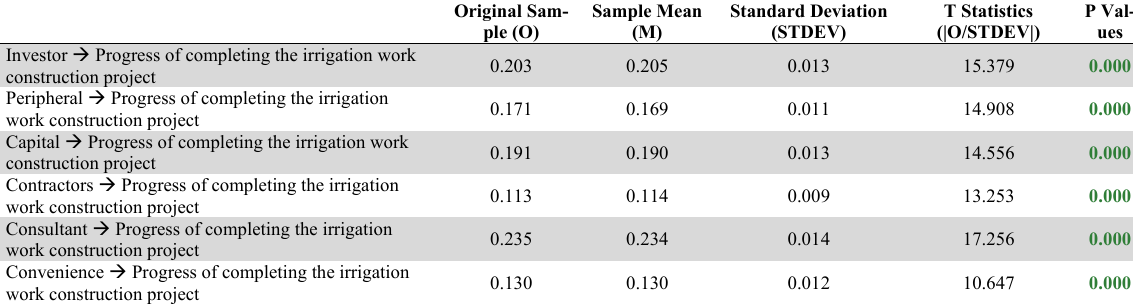
Summary of research